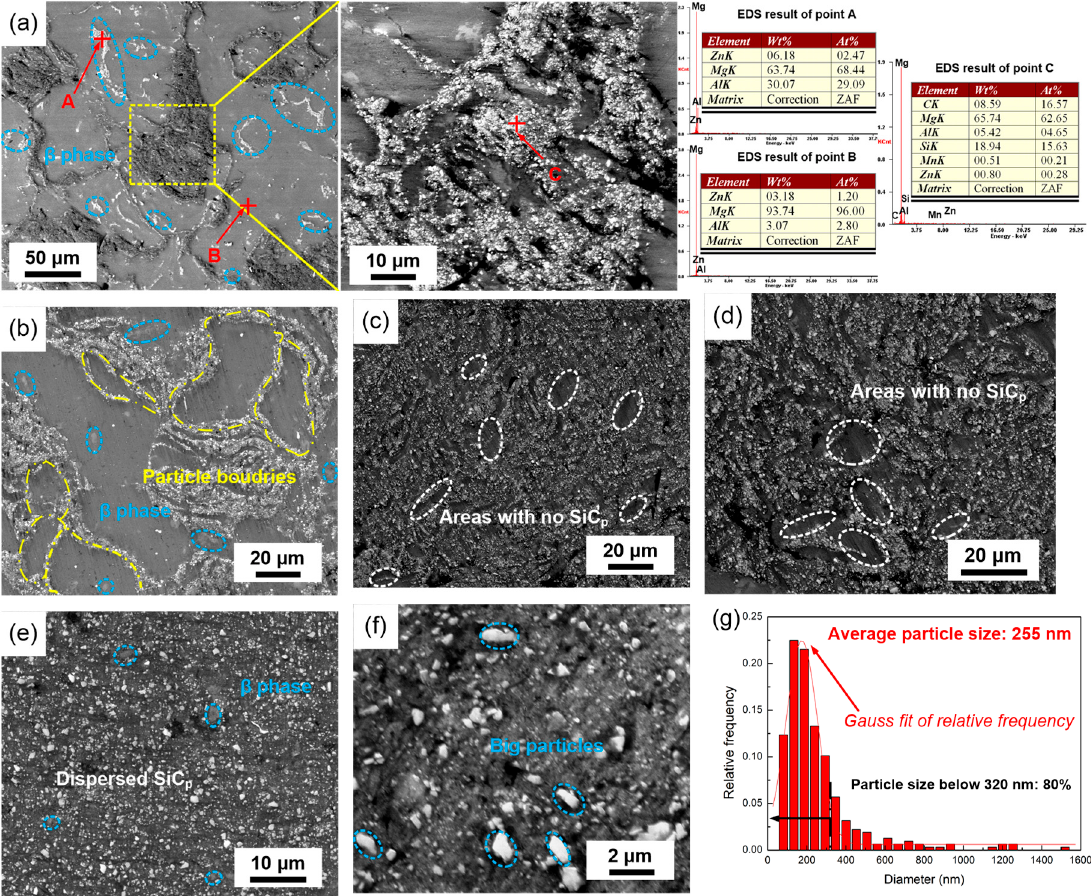
Figure 5. Microstructural evolution of SiCp/AZ91 composite: ( a ) 15 min; ( b ) 30 min; ( c ) 60 min; ( d ) 120 min; ( e ) 180 min; ( f ) 240 min ( g ) the particle size distribution of Figure 5f.